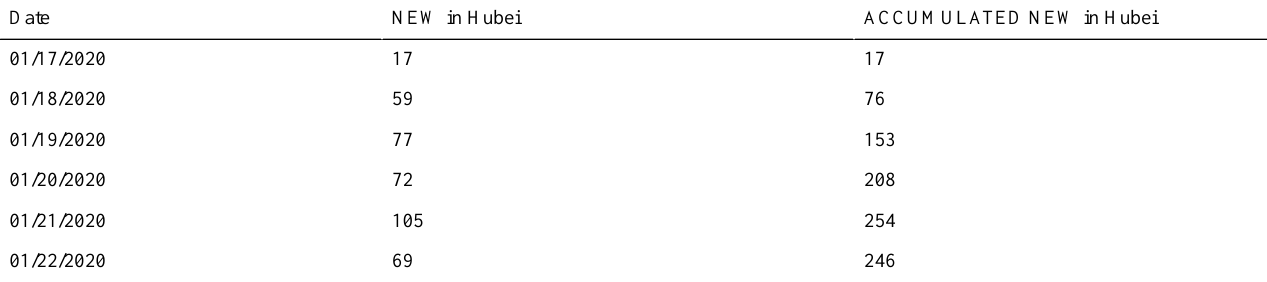
Table 1. The NEW and ACCUMULATED NEW data in Hubei Province from January 17-22, 2020.